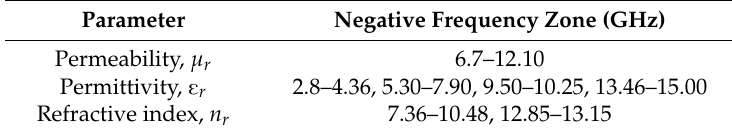
Table 2. The permeability, permittivity, and refractive index in the negative frequency